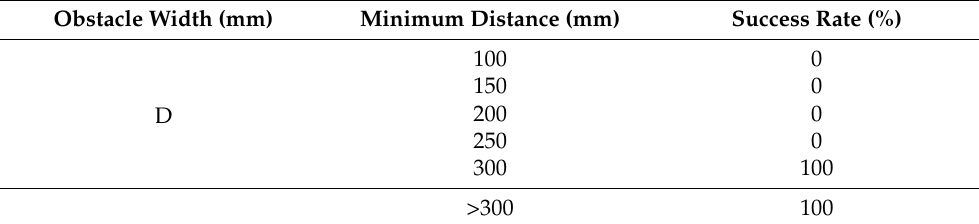
Figure 16. Obstacle avoidance and turning experiment of prototype. Table 5. Complete the minimum distance test of obstacle avoidance function. Table 5. Complete the minimum distance test of obstacle avoidance function.